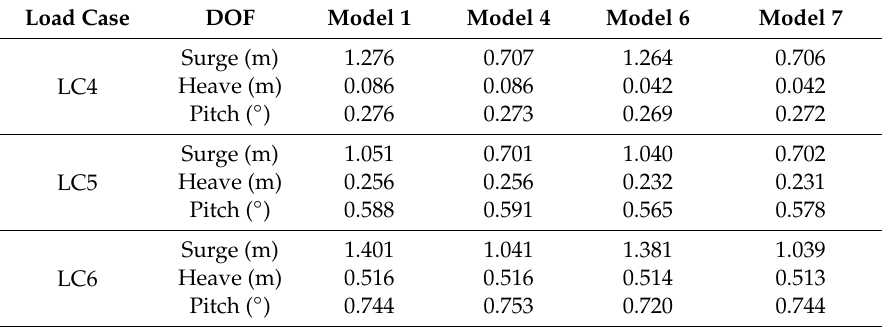
Figure 26. Comparison of the pitch motion of Model 1, 4, 6, and 7 in the frequency domain: ( a ) LC4; ( b ) LC5; and ( c ) LC6. Table 17. Motion standard deviation of Models 1, 4, 6, and 7 under irregular waves.